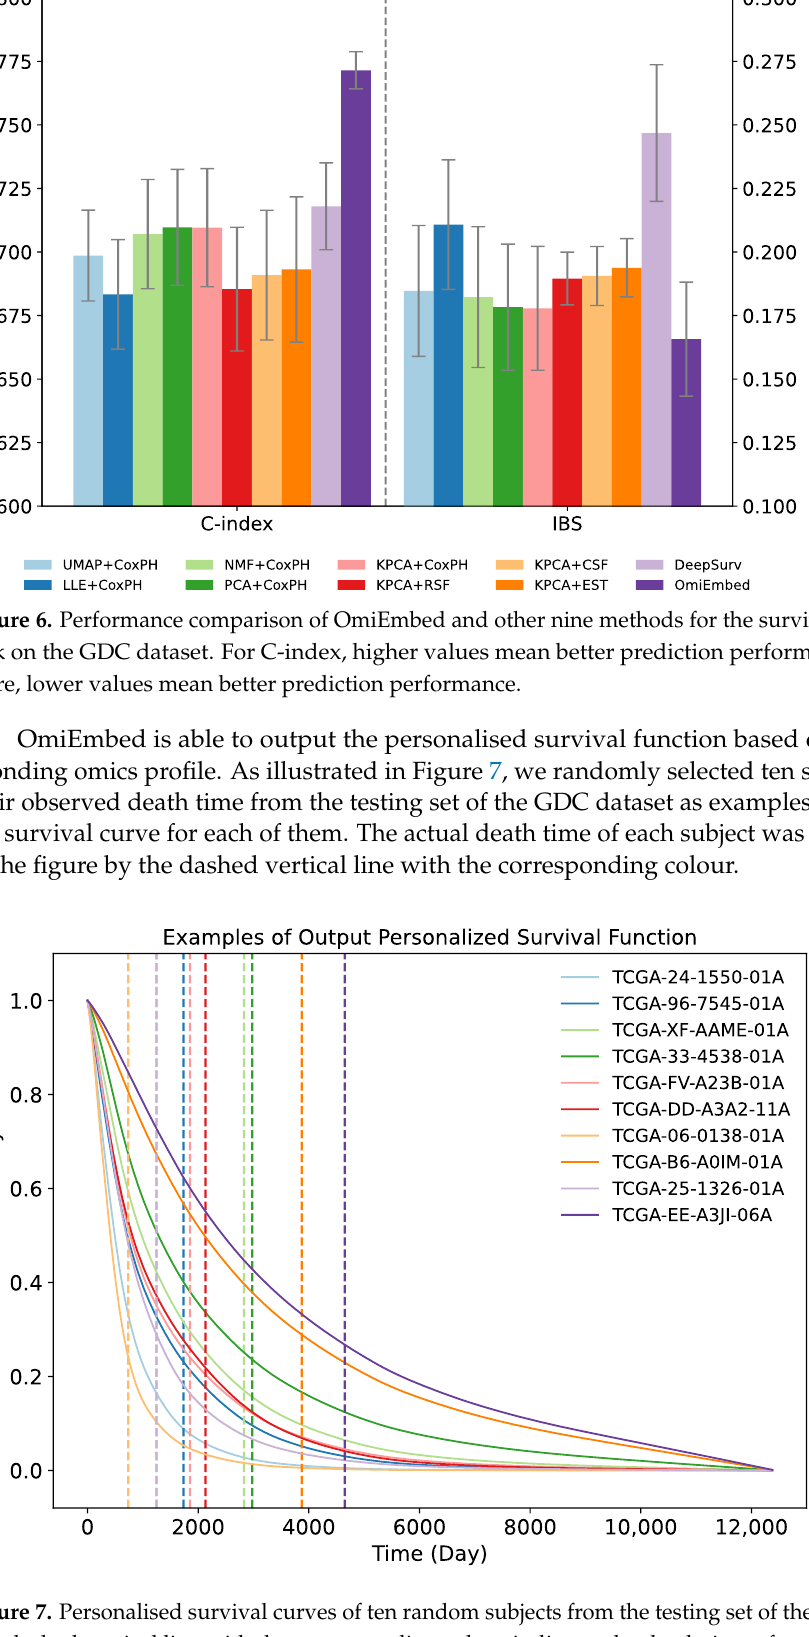
Figure 7. Personalised survival curves of ten random subjects from the testing set of the GDC dataset. The dashed vertical line with the corresponding colour indicates the death time of each